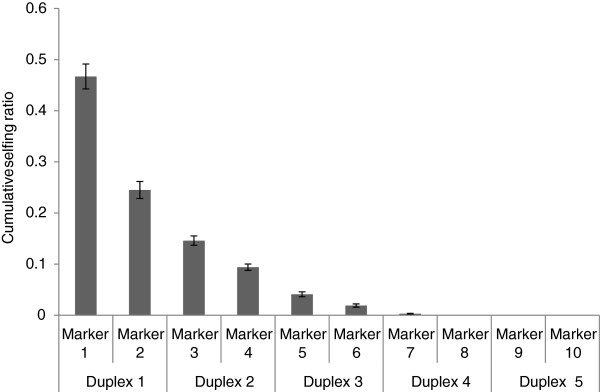
Cumulative selfing ratio with increasing the number of loci. The duplex sets were randomly selected on different linkage groups. The bar indicated standard error.